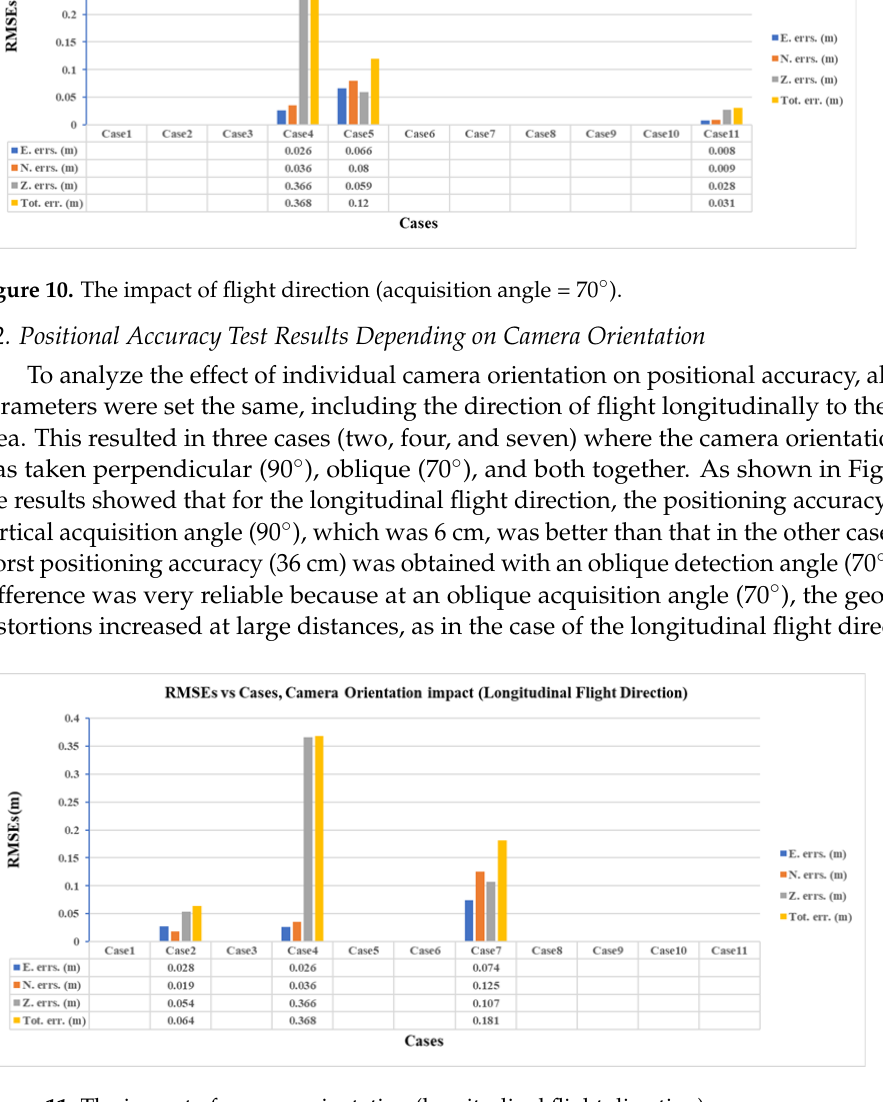
Figure 11. The impact of camera orientation (longitudinal flight direction).